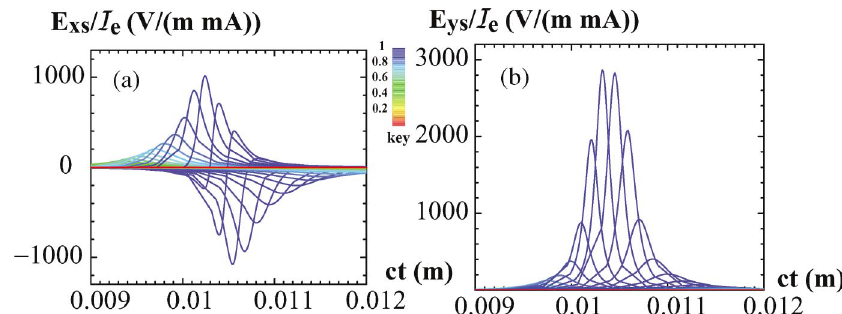
(a) and E (b) as functions of time t as experienced by a test xs ys